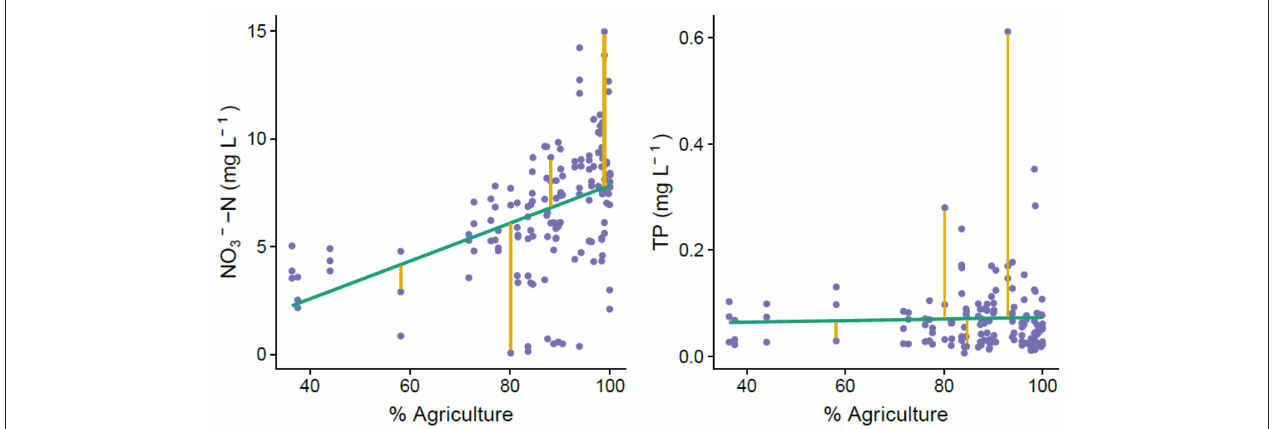
FIGURE 3 | Visualization of how we calculated residuals in the relationship between agricultural land use and nutrient concentrations for each catchment. Because agriculture is the predominant nutrient source in the Brittany region, we used departure from the relationship between agriculture and nutrient concentration as a metric of nutrient attenuation capacity. Points above the regression line represent less attenuation capacity because there is more nutrient in the system than would be expected with this rough estimate of nutrient inputs.